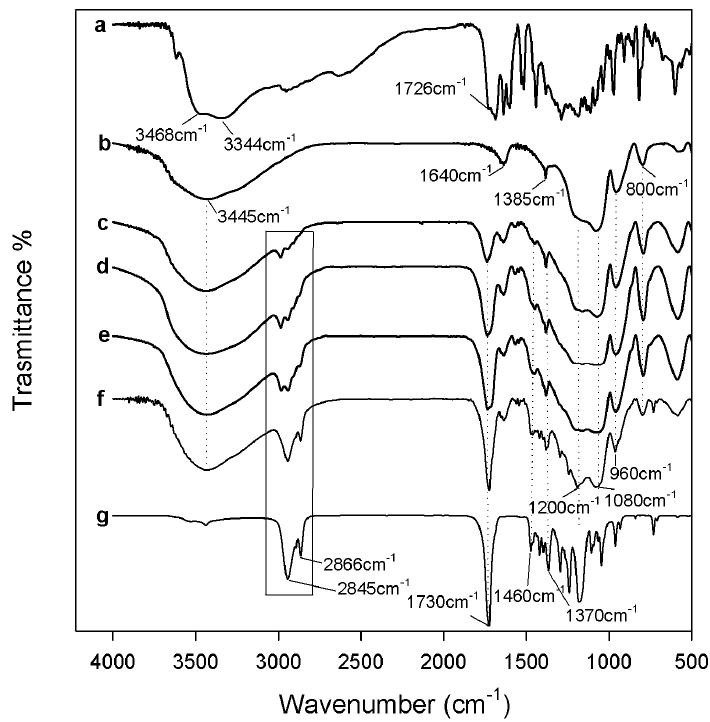
Figure 3. Representative FTIR spectra ( a ) CGA; ( b ) SiO 2 ; ( c ) SiO 2 /PEG 6wt % /CGA 20wt % ; ( d ) SiO 2 /PEG 12wt % /CGA 20wt % ; ( e ) SiO 2 /PEG 24wt % /CGA 20wt % ; ( f ) SiO 2 /PEG 50wt % /CGA 20wt % ; ( g ) PEG.